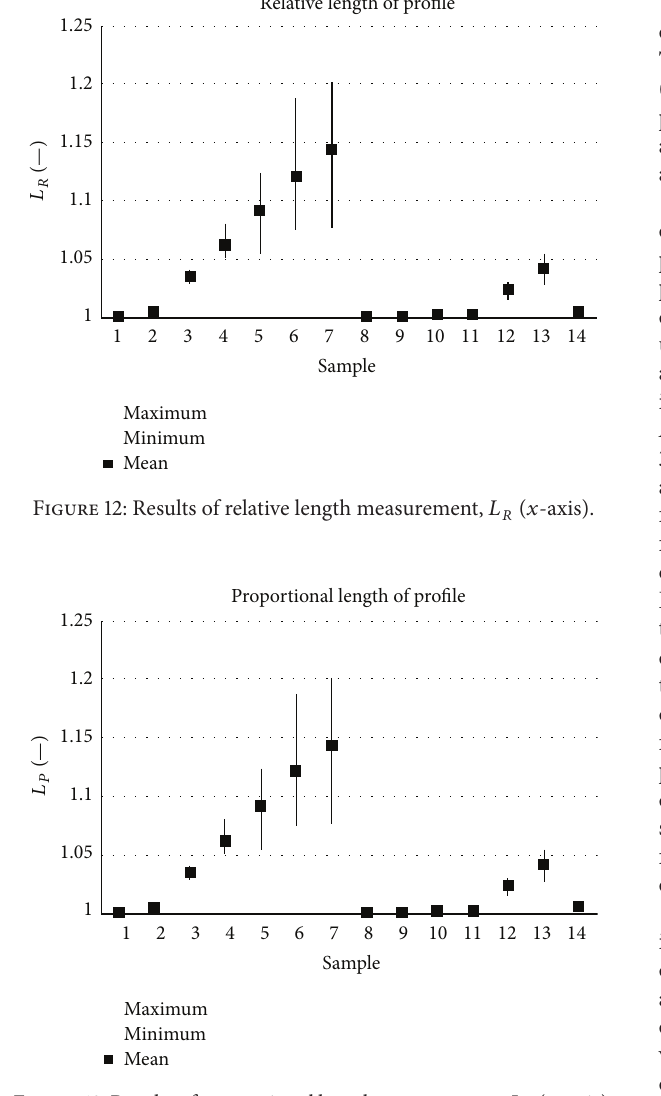
oriented structure that is identified as a random